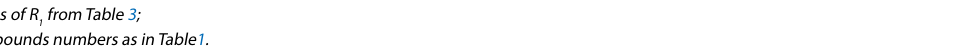
a values of R from Table 3; 1 b compounds numbers as in